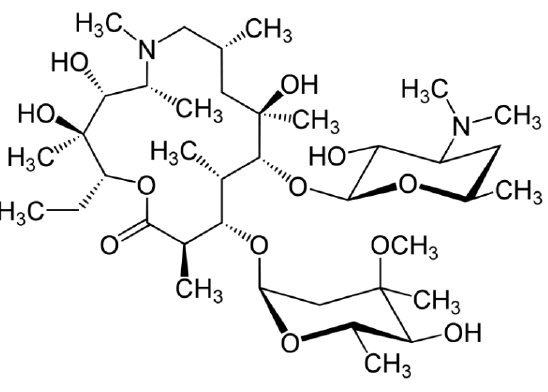
Figure 1. Molecular structure of azithromycin.